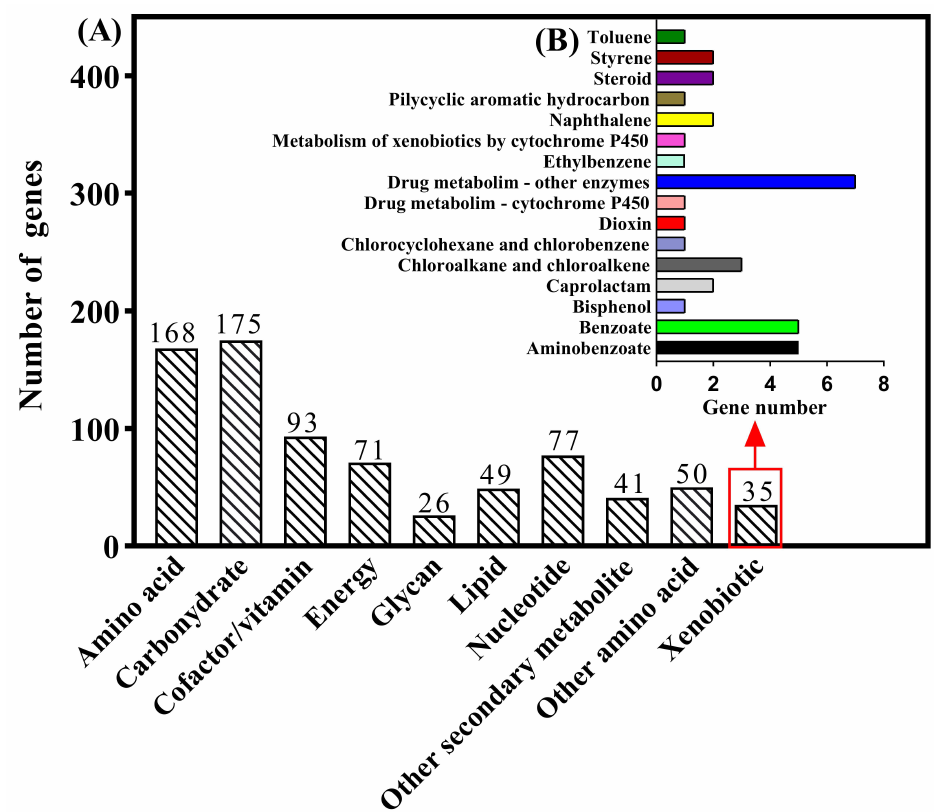
Figure 4. Metabolism of strain MZT7. ( A ) Genes distributed in the KEGG categories. ( B ) Genes involved in the KEGG pathways for xenobiotics biodegradation and